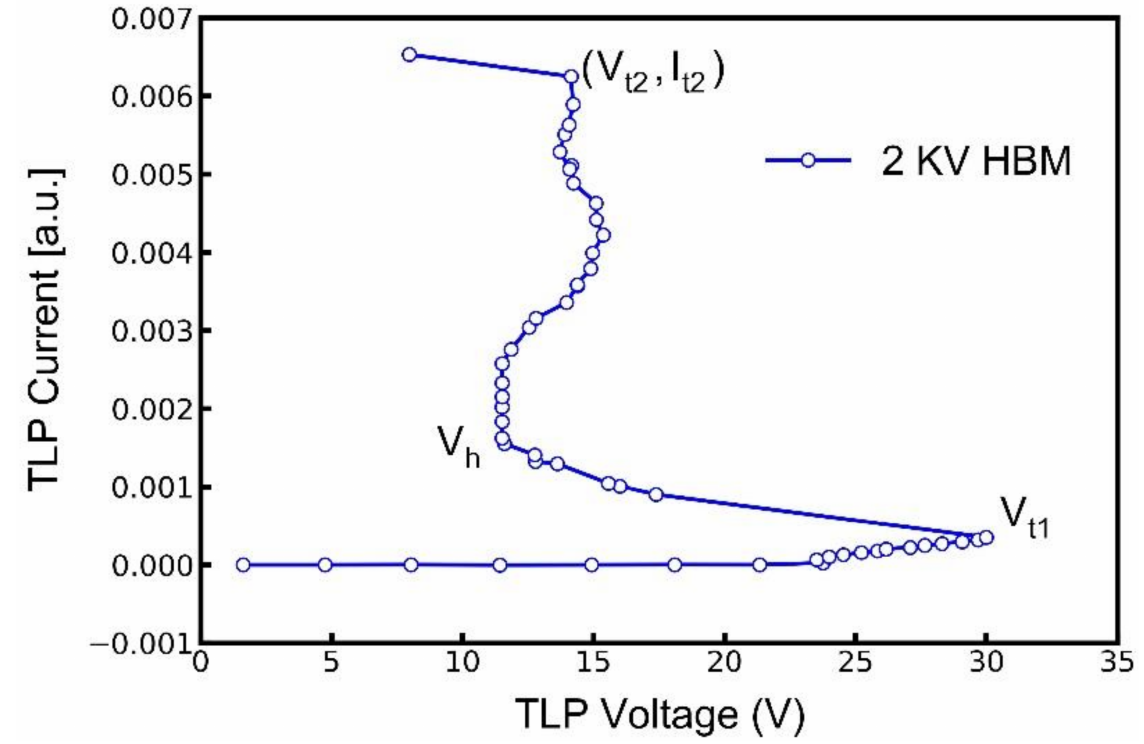
Figure 6. Measured TLP I-V curve for ESD protection circuit.